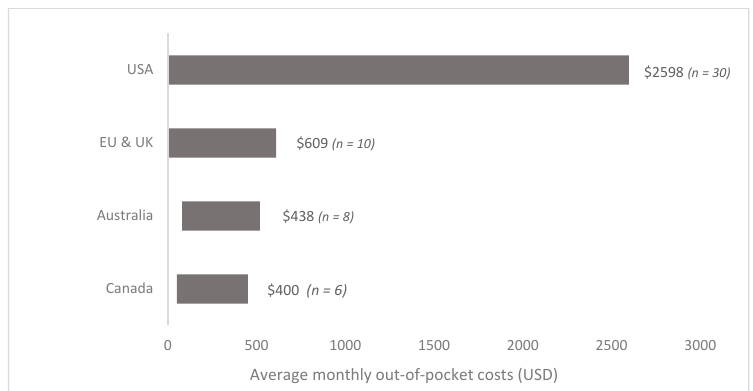
Figure 2. Range of monthly out-of-pocket costs per patient by country. Countries in the European Union (EU) include Italy, France, Ireland, and Germany. Costs are expressed in 2018 USD. Not enough data were available to include a range of costs (in 2018 USD) for other countries. Average costs per patient per month were also estimated: USD 300 in the U.S., USD 200 in Canada, USD 180 in the E.U. and USD 70 in Australia Not enough data were available to stratify these estimates by cancer site.